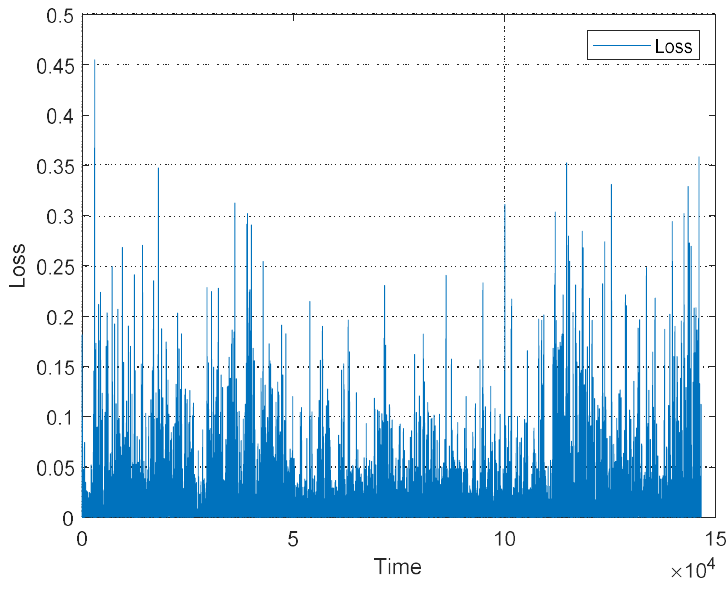
Figure 9. Loss of auto-designed DNN.